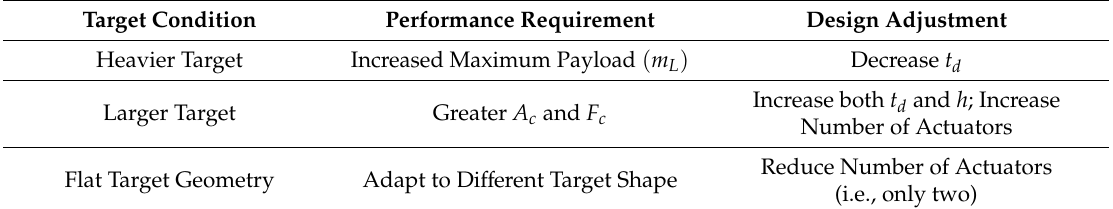
Figure 13. Air-driven hyperelastic actuators at the tip of discrete robotic fingers for soft touch applications developed at Western University. Table 3. Summary of design guidelines.